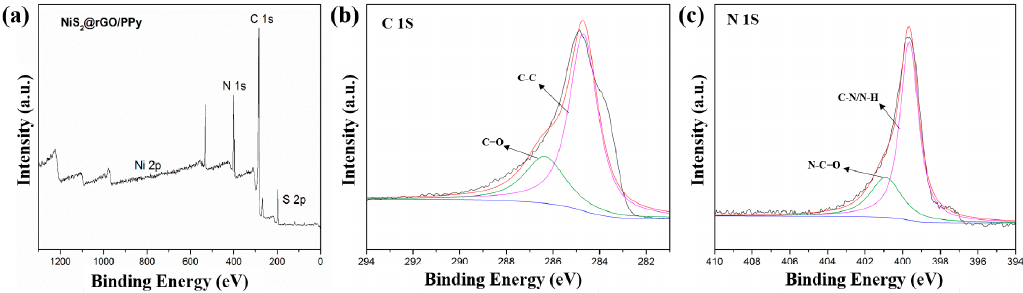
Figure 2. X-ray photon spectroscopy (XPS) spectra of NiS 2 @rGO / PPy ternary composite ( a ); XPS core-level spectra of C 1s ( b ) and N 1s ( c ) of NiS 2 @rGO / PPy.